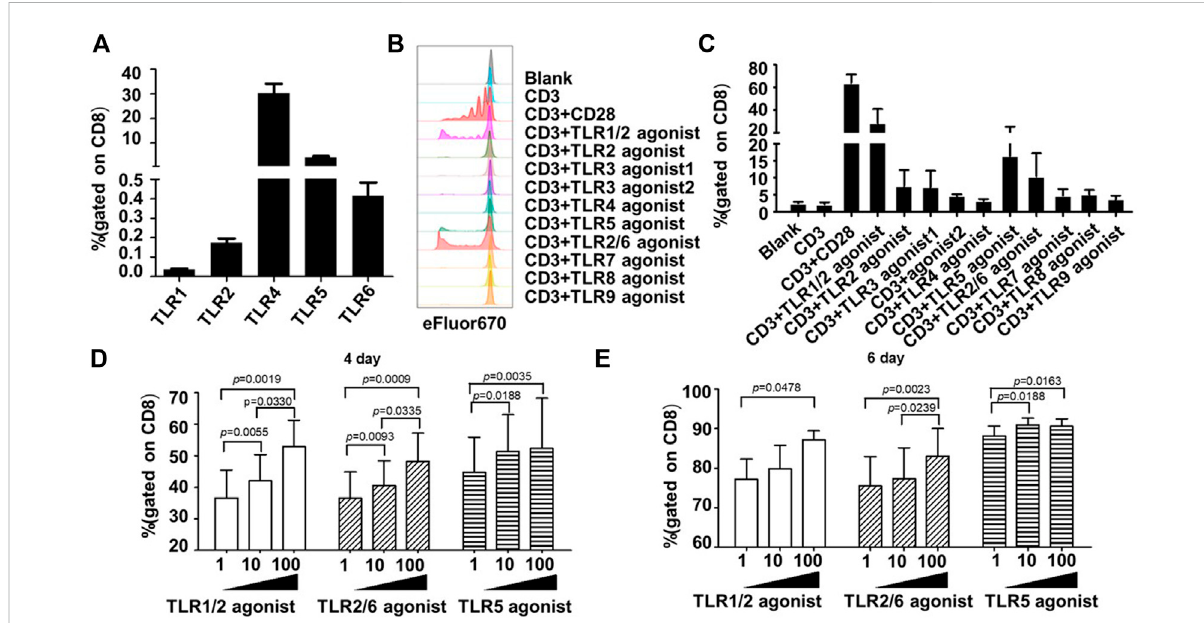
FIGURE 1 Co-stimulation with TLR1/2, TLR2/6, and TLR5 agonists enhances the proliferative response of human blood-derived CD8 + T cells to TCR triggering. (A) Expression pro fi les of surface TLRs in resting CD8 + T cells within human blood mononuclear cells (PBMCs). The T cell subpopulations of human PBMCs were identi fi ed by staining the cells with antibodies against CD3, CD4, and CD8; the TLR expression was measured by fl ow cytometryandexpressedasthepercentageofpositivelystainedcells.Shownisaggregateddataof12samples. (BandC) Co-stimulatoryeffects of different TLR agonists on the proliferation of human PBMC-derived CD8 + T cells. CD8+T cells were puri fi ed from human PBMCs, stained with